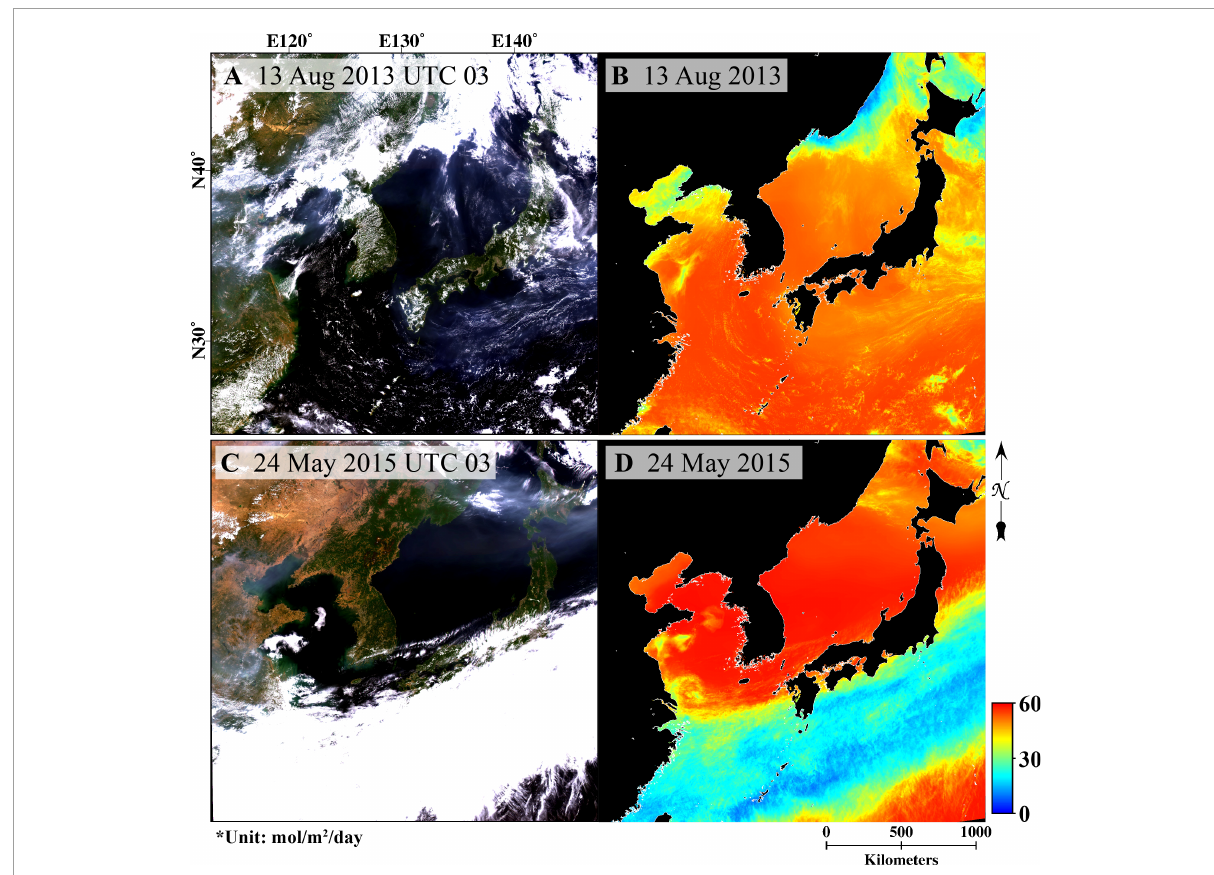
FIGURE 6 Composite true color red–green–blue (RGB) images of GOCI and GOCI daily PAR. (A) GOCI RGB composite image from UTC 03 Aug 13, 2013. (B) Daily PAR image from Aug 13, 2013. (C) GOCI RGB composite image from UTC 03 May 24, 2015. (D) Daily PAR image from May 24,